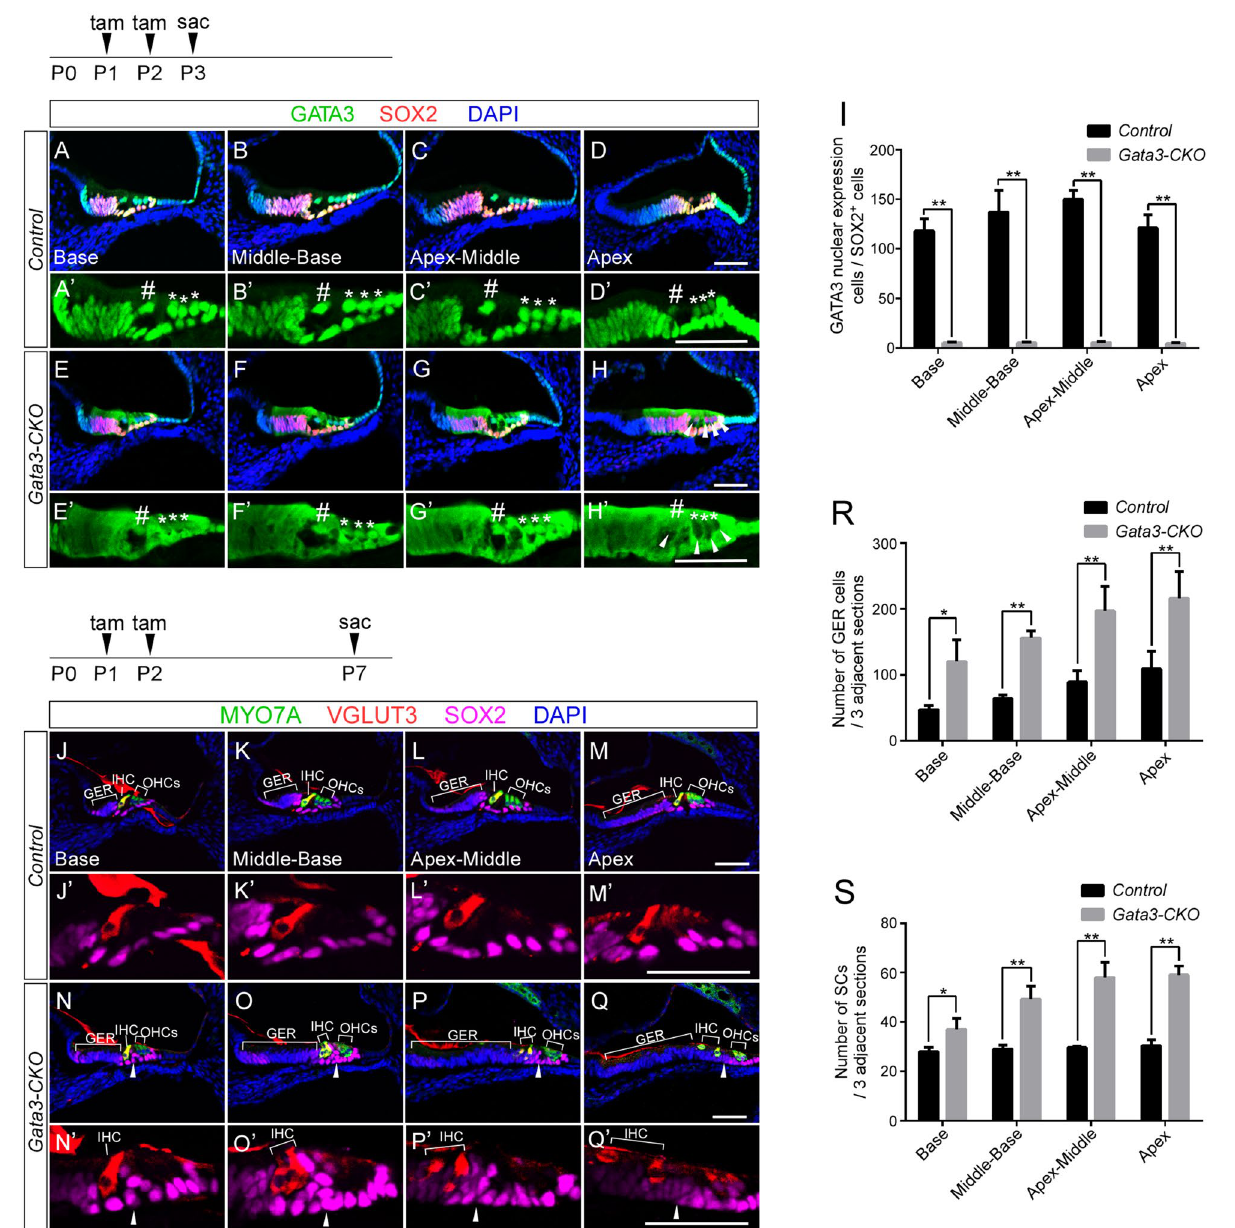
Figure 2. Gata3 deficiency leads to increased number of SCs and expansion of the GER region. ( A – D , A ′ – D ′ ) The expression of GATA3 (green) is localized in the nuclei of SOX2 + (red) SCs in control cochleae at P3 after the administration of tamoxifen at P1 and P2. ( E – H , E ′ – H ′ ) In Gata3- CKO cochleae, the specific nuclear expression of GATA3 is lost in the SOX2 + SCs but the nuclear expression of GATA3 in HCs is not affected except at the apex ( H , H ′ , arrowheads). IHCs and OHCs are indicated with pound sign (#) and asterisk (*), respectively. ( I ) Quantification of the number of SOX2 + SCs with GATA3 nuclear expression in 3 adjacent sections (a total thickness of ~ 54 μm) shows the high rate of Gata3 deletion in Gata3- CKO mice. n = 3; **p < 0.01. ( J – M , J ′ – M ′ ) Immunolabeling of the control cochlea with anti-VGLUT3 (red), anti-MYO7A (green) and anti-SOX2 (magenta) reveals the normal pattern of SCs and the orderly arrangement of three rows of OHCs and one row of IHCs at P7 after the administration of tamoxifen at P1 and P2. ( N – Q , N ′ – Q ′ ) In Gata3- CKO cochleae, the orderly pattern of HCs is disrupted along with an increase in SCs (arrowheads) and an expansion of the GER region (bracket). ( R , S ) Quantification shows that the numbers of GER cells ( R ) and SCs ( S ) in 3 adjacent sections (a total thickness of ~ 54 μm) are significantly increased in Gata3- CKO cochleae compared with control mice. n = 3; *p < 0.05; **p < 0.01. Scale bars are 50